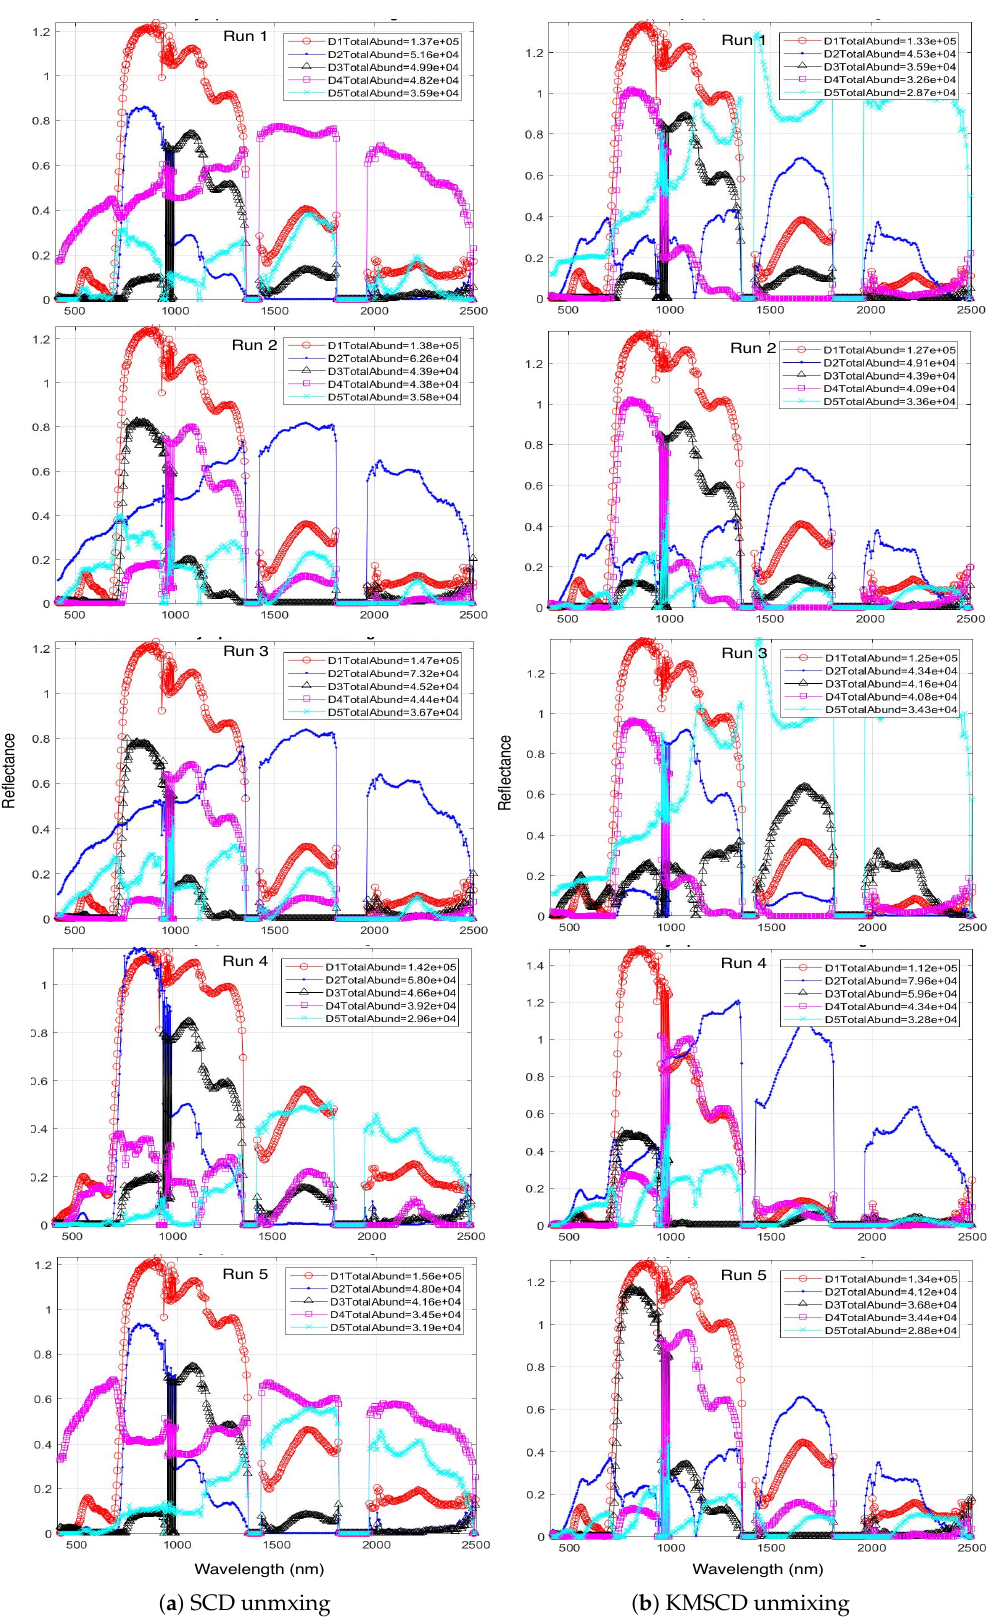
Figure 4. Most abundant endmembers (EMs) for the for five runs with 40 EMs between ( a ) SCD-unmixing with random sample selection and ( b ) the proposed K-Means SCD algorithm (KMSCD)